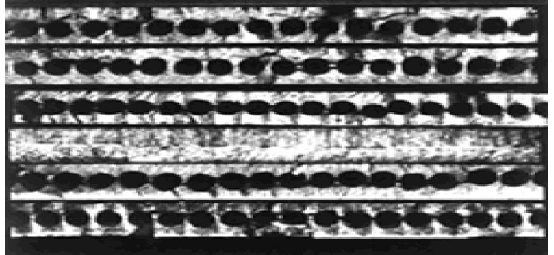
Fig. 6b. Typical bending fatigue failures of the nickel specimens tested.